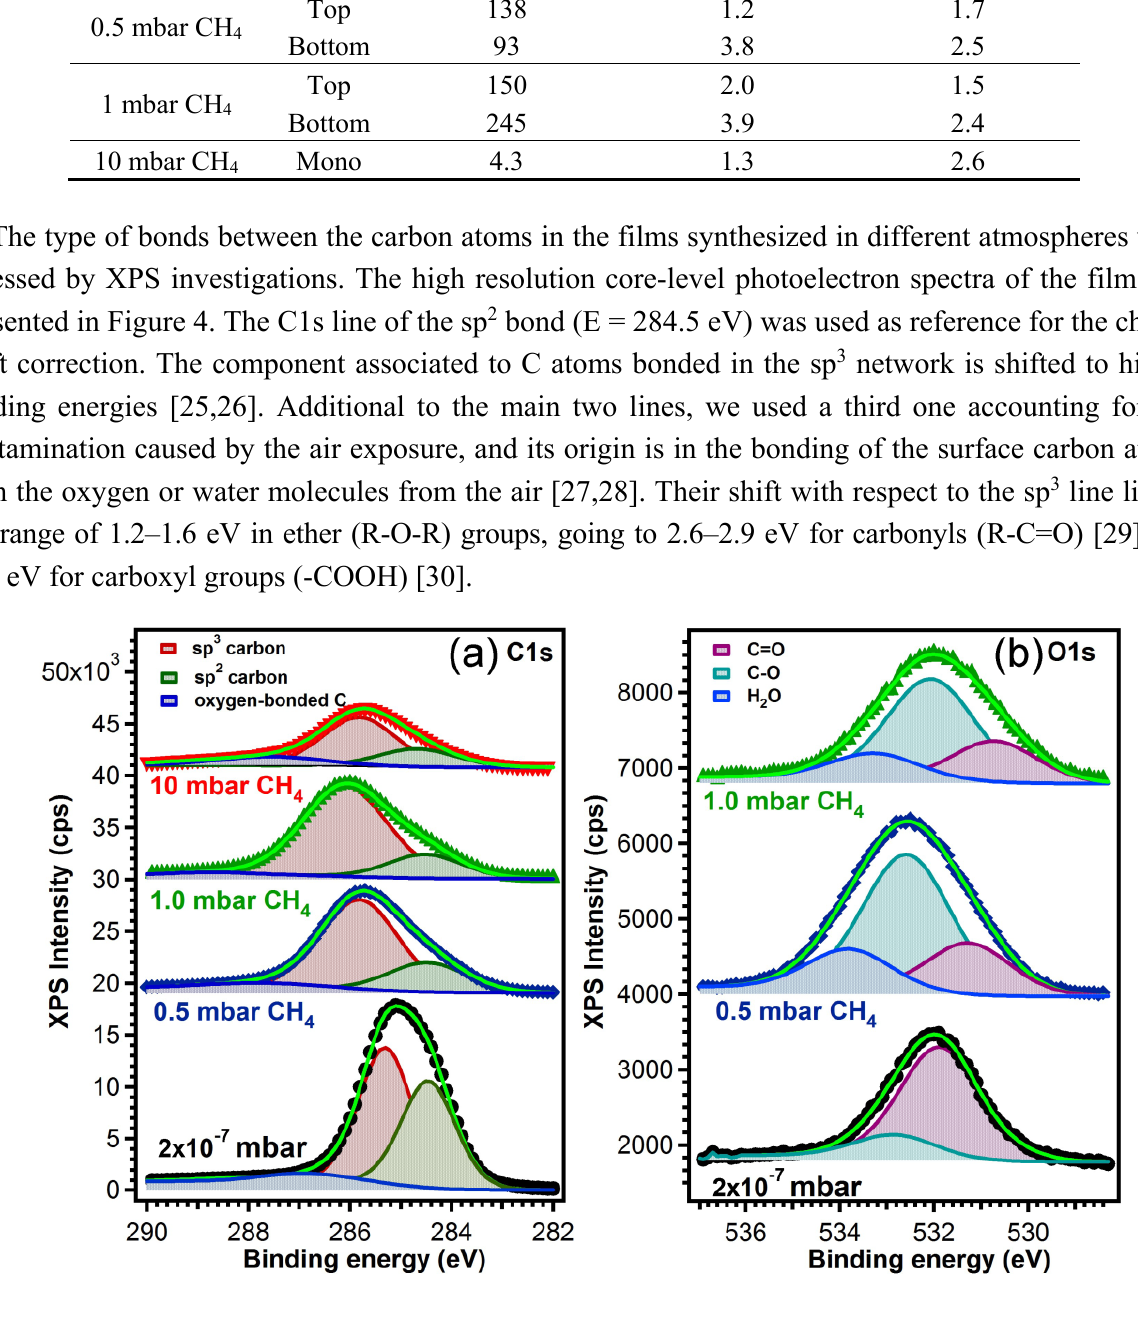
Figure 4. ( a ) C1s core level X-ray photoelectron spectroscopy (XPS) spectra for the samples prepared in vacuum and in different ambient pressures on buffered Si (100) substrates; ( b ) O1s core level XPS spectra for the samples prepared in vacuum and at 0.5 mbar and 1 mbar CH 4 pressure on buffered Si (100)